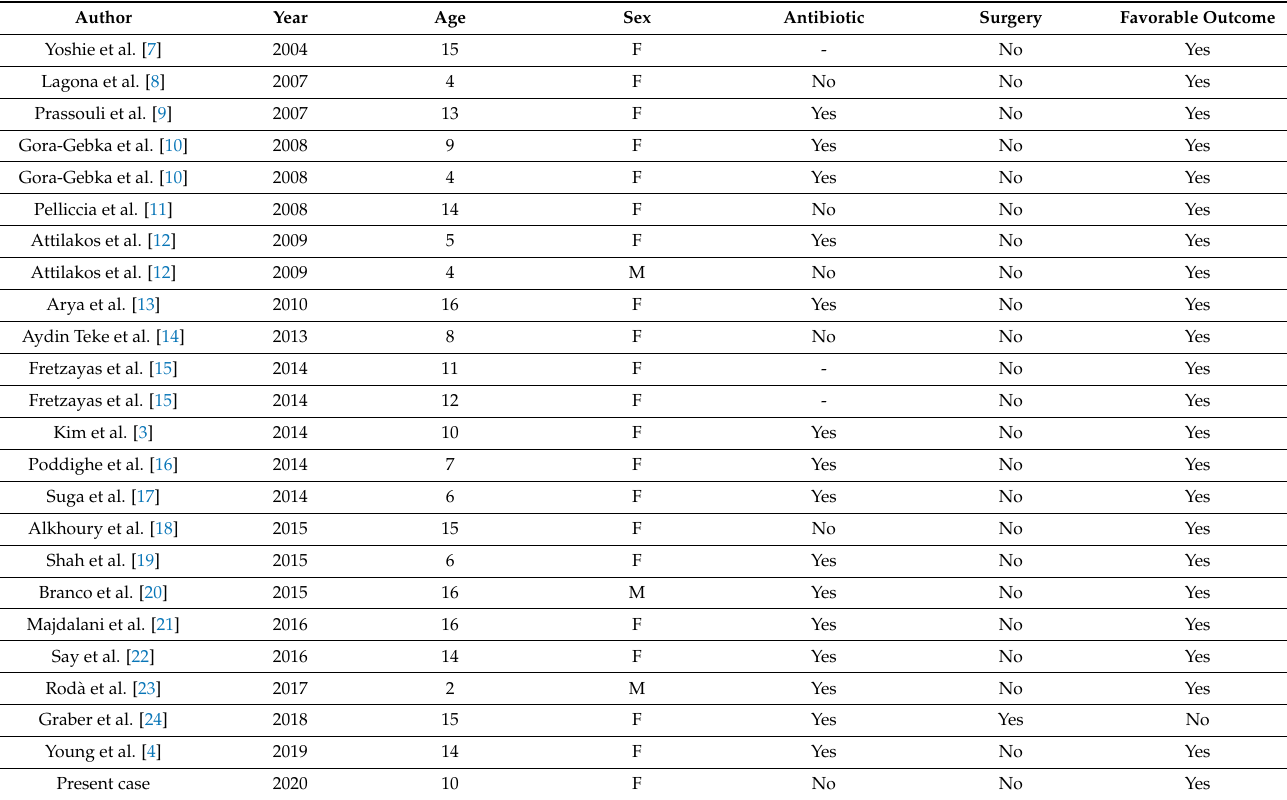
Table 1. Cases of Epstein–Barr virus-associated acute acalculous cholecystitis in pediatric